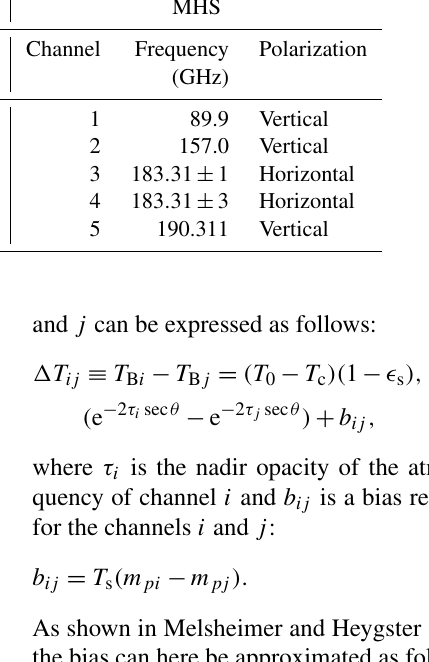
Table 1. Frequency and polarization details for each channel of AMSU-B and MHS sensors. AMSU-B MHS